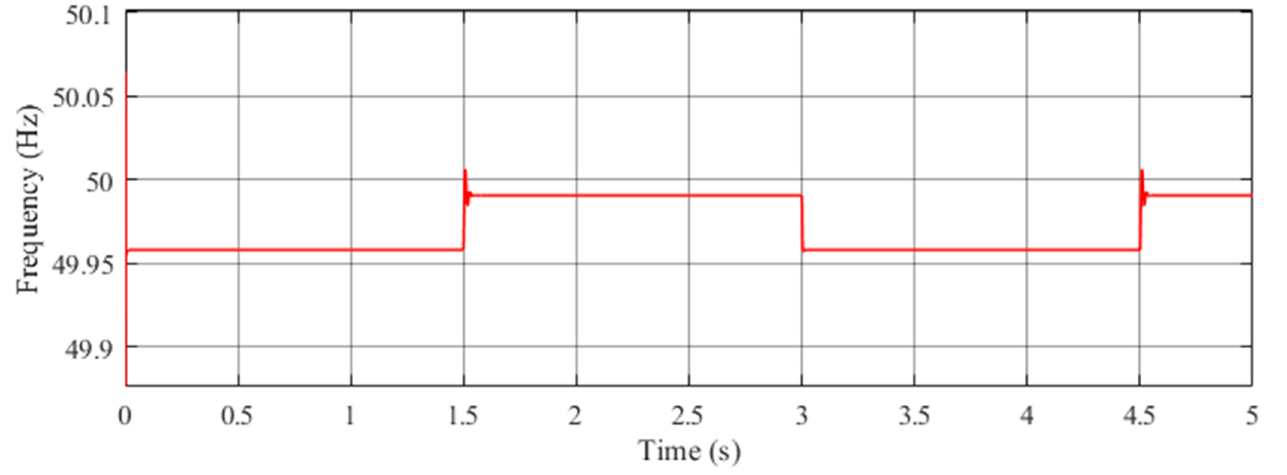
Figure 20. Frequency control during solar radiations variations.